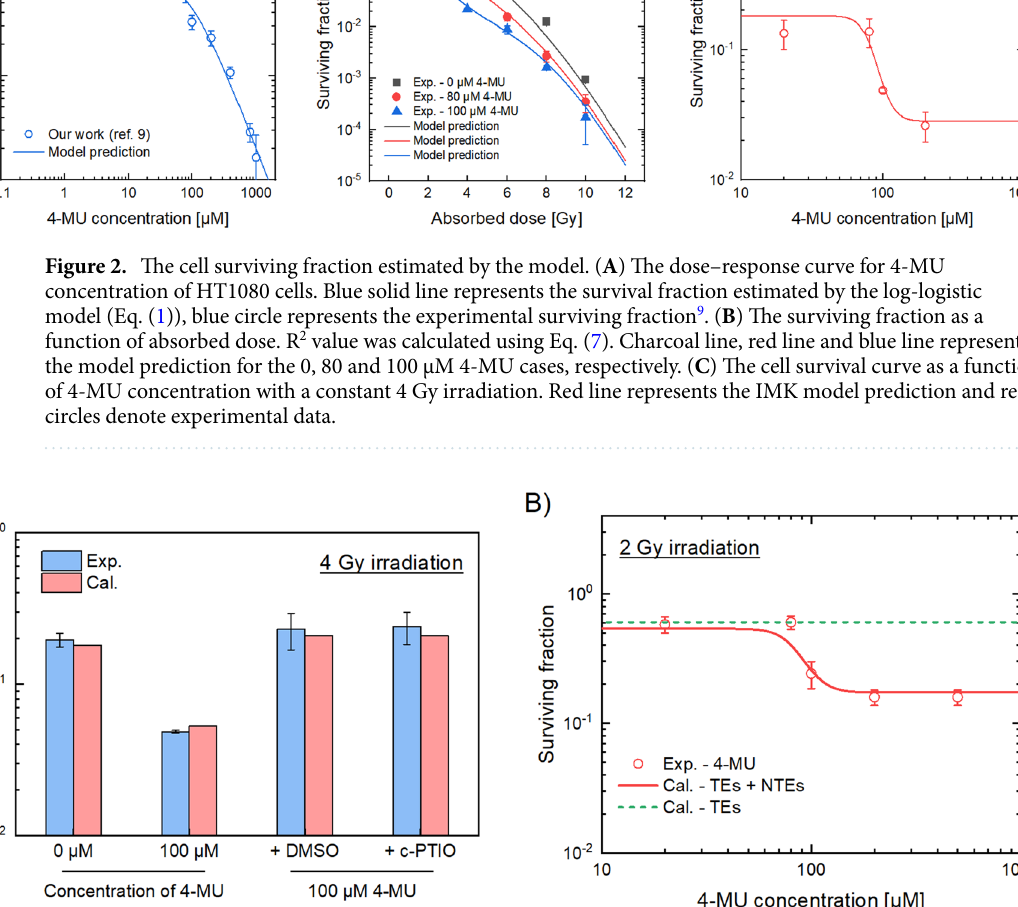
Fig. 3A, for the groups treated with 4-MU and 4 Gy X-ray irradiation, the surviving fraction of the cells treated with 1% DMSO or 40 μM c-PTIO agreed well with the model prediction considering only TEs with δ = 0. In addi- tion, Fig. 3B shows the survival fraction as a function of the 4-MU concentration at a constant 2 Gy irradiation. These comparisons clearly exhibit that the IMK model in this study fairly reproduces the experimental results. Oxidative stress level under 4‑MU administration. To further evaluate the NTE-related radiosen- sitizing effects under 4-MU administration, the intracellular overall oxidative stress levels (i.e., ROS and NO production levels) were measured by using flowcytometry after 4 Gy X-ray irradiation in the presence of 100 μM 4-MU (Fig. 4 and Table 2). At 0 h after the treatment, the oxidative stress levels increased 1.2-fold for 4 Gy irradiation alone group, 4.2-fold for 4-MU alone group, and 4.8-fold for combined group, compared to the control group. At 2 h after the treatment, the 4 Gy irradiation alone group decreased to the same level as the control group, whereas the level drastically increased under 4-MU administration. Especially, at 24 h after the treatment, 4-MU administration alone group and combine group decreased whilst the 4 Gy irradiation alone group increased to 1.4-fold. As shown in the previous studies 50,51 , the radiation-induced oxidative stress level occurs immediately after irradiation, then the antioxidant activity such as superoxide dismutase and the expres-